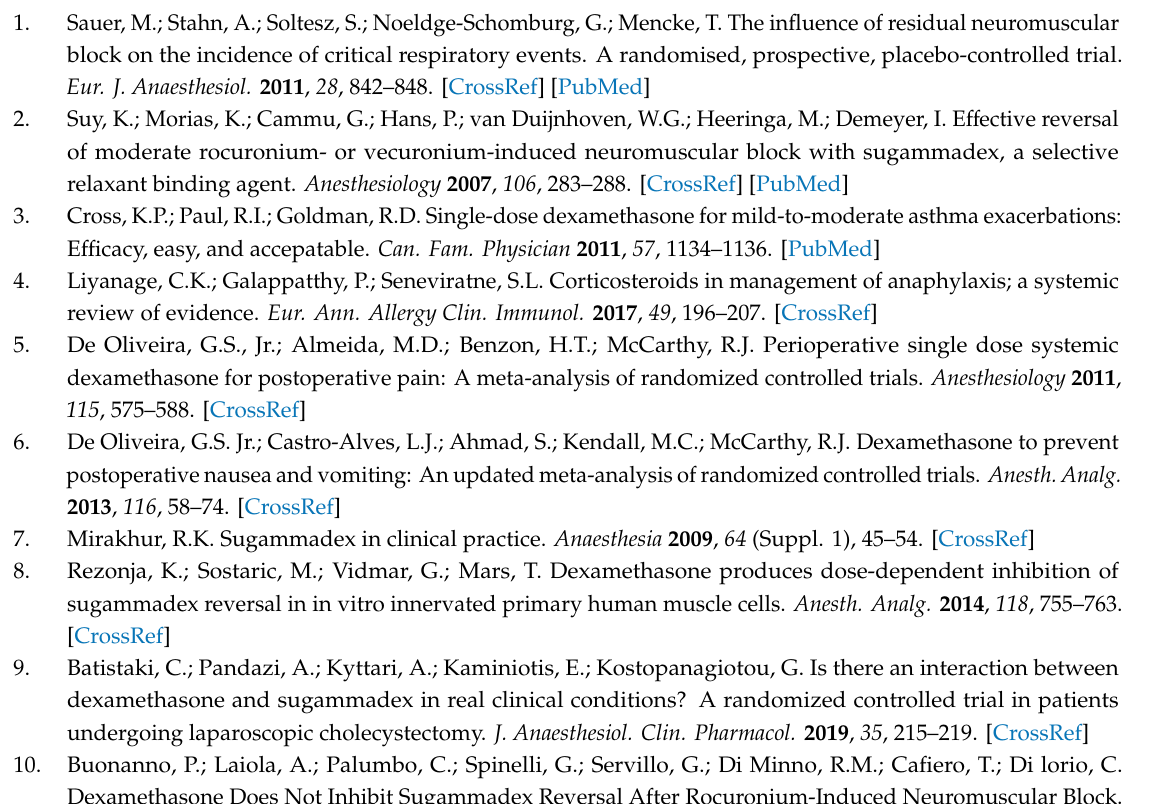
Table S1: Search strategy for each database, Table S2: Details for judgement for each risk of bias for randomized controlled studies, Table S3: Details for judgement of each quality assessment for non-randomized controlled studies. Figure S1: Risk of bias summary and